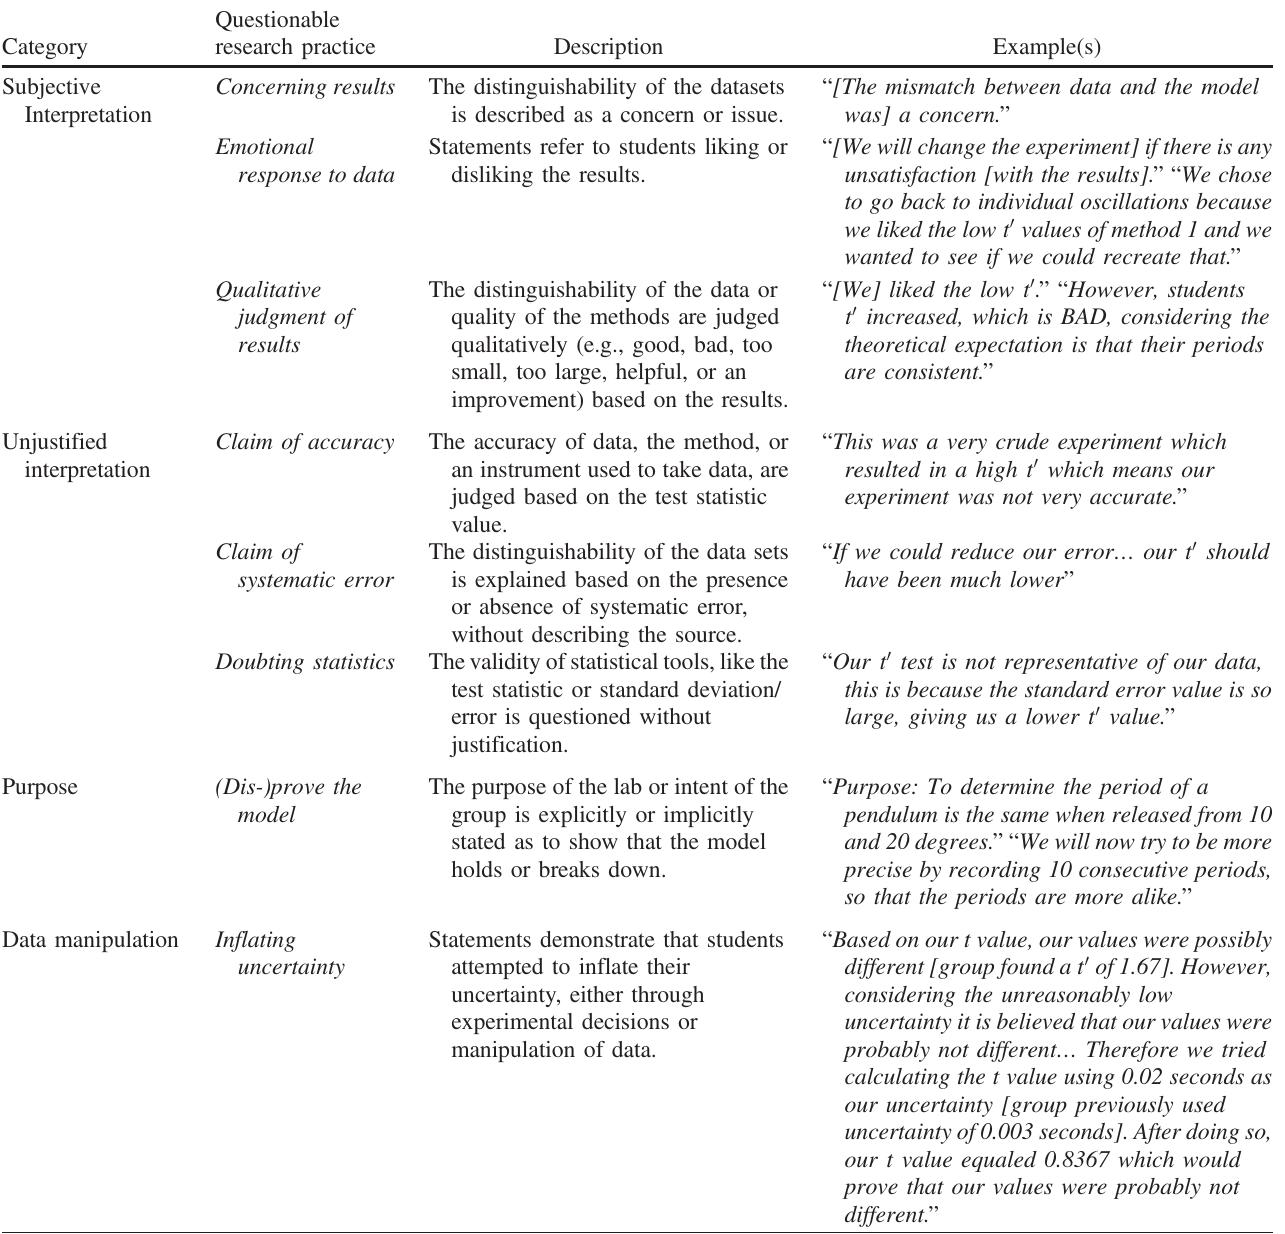
TABLE I. Coding scheme of questionable research practices recorded in groups ’ lab notes that was developed from groups ’ lab notes as described in Ref. [34]. Codes and descriptions are reproduced from Ref. [34] and examples are provided for